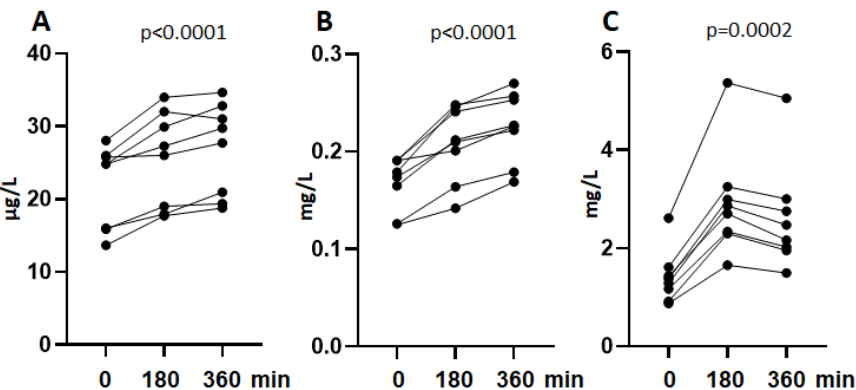
Figure 3. Shedding of sSIRP α in vivo . The concentration of sSIRP α ( A ), sCD206 ( B ), and sCD163 ( C ) were measured at t = 0, t = 180 and t = 360 min in blood samples from 8 healthy individuals. Participants were injected with a bolus of LPS at t = 0. Repeated measures ANOVA.